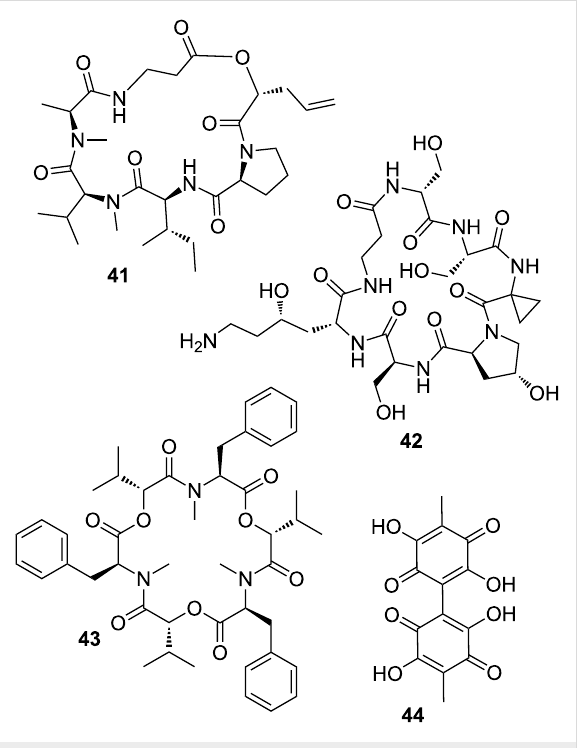
Figure 11: Entomopathogenic fungi use secondary metabolites as insecticidal compounds to kill their prey. Destruxin A ( 41 ), serinocyclin A ( 42 ), beauvericin ( 43 ), and oosporein ( 44